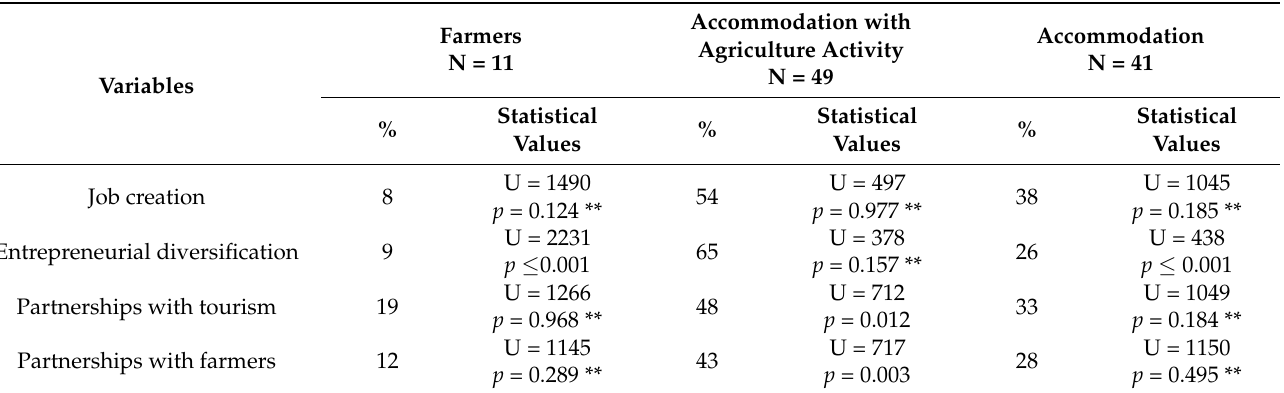
Table 7. A comparison of economic variables between accommodation and other entrepreneurial agritourism models (U-Mann–Whitney test of quantitative variables).